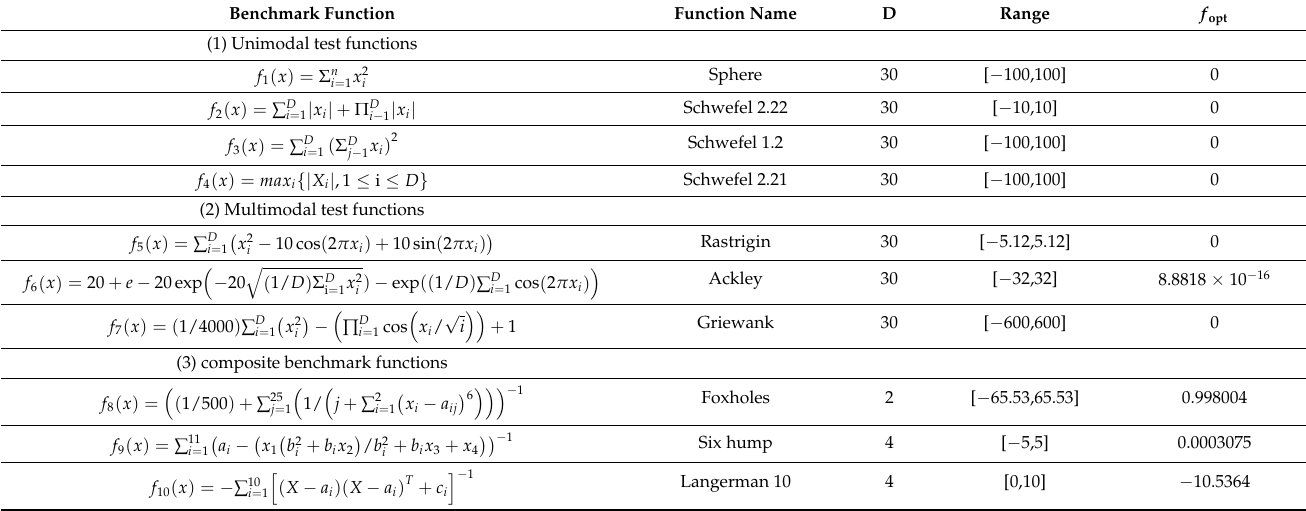
Table 2. Benchmark functions.